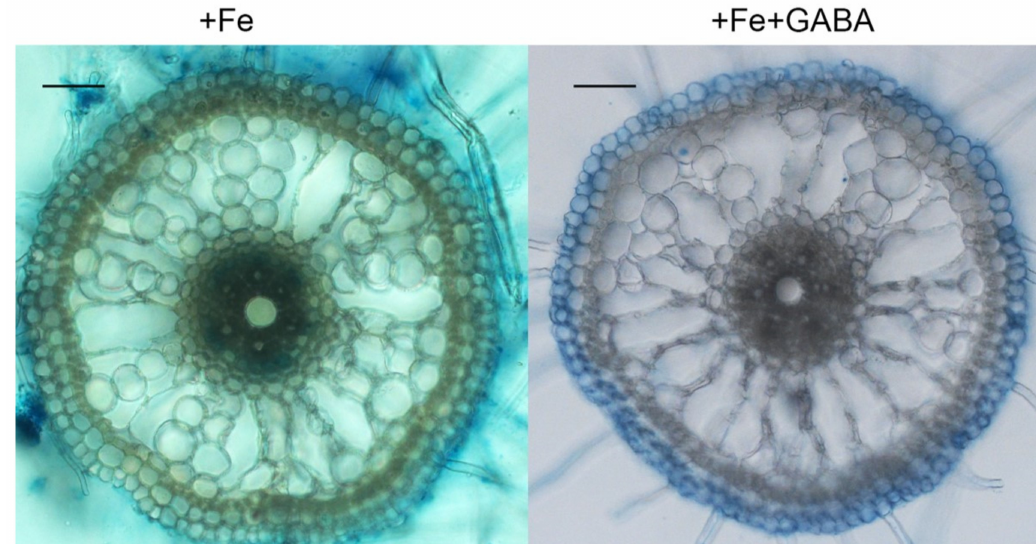
Figure 4. Effect of GABA on ferric accumulation in the roots under conditions of FS. Three-day-old seedlings were treated with 0.5 mM GABA for one week and then roots were stained with Perls’ blue stain to visualize ferric accumulation. Hand-cut sections were observed and pictured. Bars = 50 µ